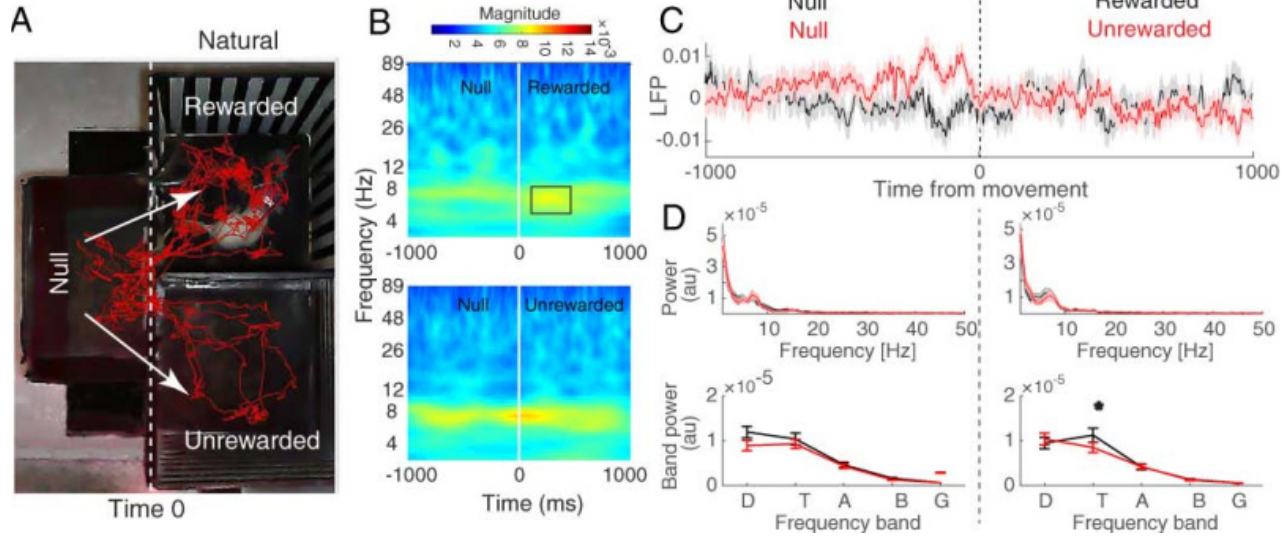
Figure 5. Hippocampal CA1 local field potential of the natural group. ( A ) Behavioral tracking of animals during LFP recording in the post ‐ test session of CPP (red line), animals received a biscuit as a natural reward in the rewarded compartment while receiving saline in the unrewarded com ‐ partment. The dashed line stands for when the rat starts to enter into the rewarded or unrewarded side. The time window was defined as one millisecond before and after the entrance to each side (dashed line). ( B ) Time–frequency representation based on CWT averaged across all recording trials and aligned to chamber entry. This figure shows the peak of theta frequency after zero (136–420 ms window). Time zero is defined as the time of entrance to each side from null (shown by the dashed line) . ( C ) Total averaged waveform (top) and mean power distributions (bottom) for the approach to the rewarded (black) and unrewarded (red) compartment calculated over a time window of 1s before and after chamber entry. Results indicate that mean theta power is increased after the en ‐ trance to the rewarded compartment. Shaded areas represent SEM. * p < 0.05 as compared with the unrewarded compartment. 3.2.1. Hippocampal CA1 Theta Activity Relation to Approach to Rewarded and Unrewarded Compartments during the Post ‐ Test in Saline ‐ Treated Animals The behavioral data showed that saline (1 mg/kg, s.c.) did not induce CPP. The red traces of freely behaving animals also represent the same result (Figure 3A). We examined the hippocampal CA1 LFPs during the post ‐ test in the two main compartments. As ex ‐ pected, time–frequency (Figure 3B) and power spectrum (Figure 3C) results showed that there was no significant difference in theta band regarding the chamber entries (paired t ‐ test, p > 0.05). In other words, no significant change was detected in the theta band during null–rewarded and null–unrewarded sessions. Therefore, these results lead us to report place difference between the two main compartments as the only variable that could not change theta activity when animals entered each compartment. 3.2.2. Hippocampal CA1 Theta Activity Relation to Approach to Rewarded and Unrewarded Compartments during the Post ‐ Test with Morphine Reward The behavioral data showed that the morphine ‐ treated animals preferred the drug compartment (rewarded compartment) to the saline compartment (unrewarded compart ‐ ment) (Figure 2A,B; middle). Red traces (Figure 4A) show that the rats spent more time in